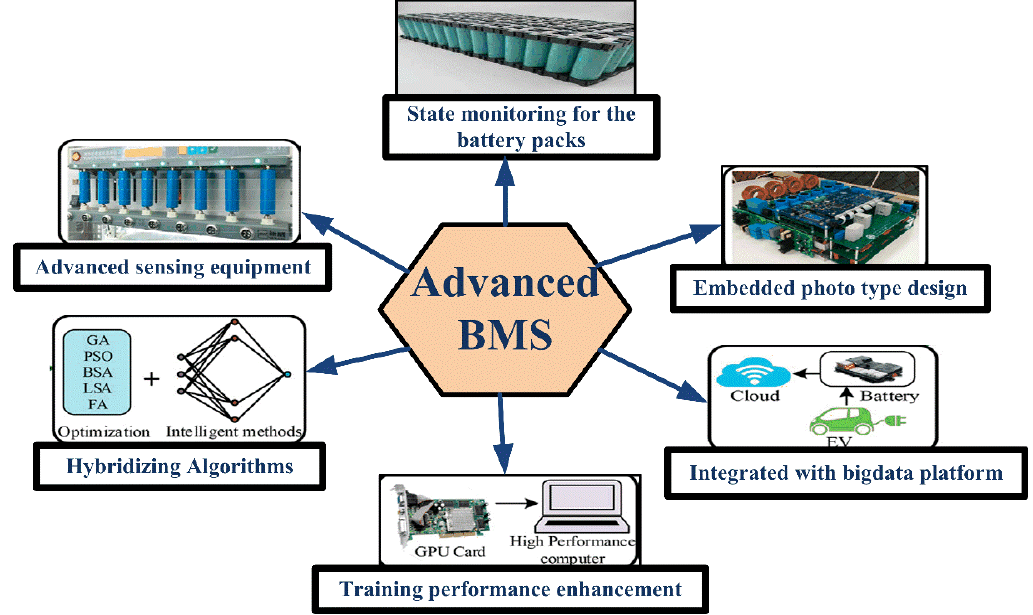
Figure 18. Future trends in advanced BMS for EV applications.